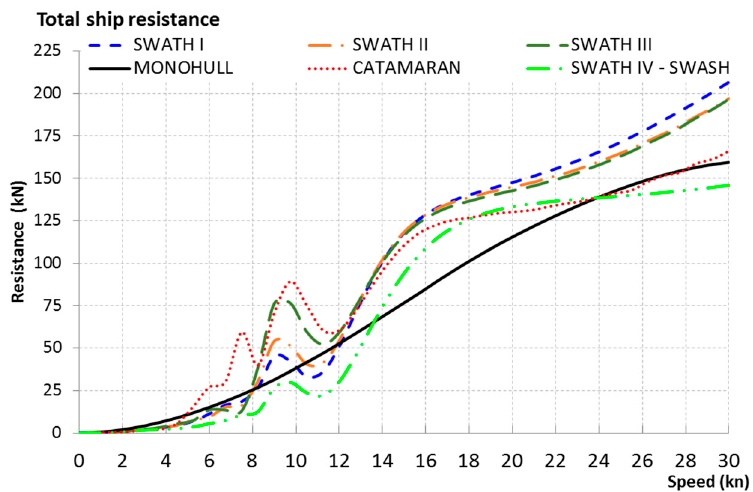
Figure 6. Approximate plot of the relationship of total resistance versus longitudinal speed for MONOHULL, CATAMARAN, SWATH I, SWATH II, SWATH III, SWATH IV–SWASH ships.